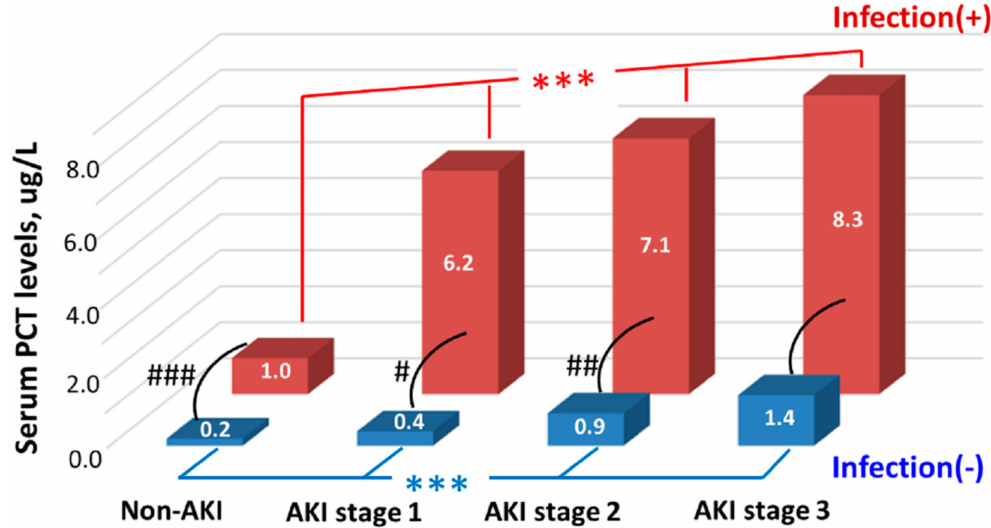
Figure 3. Serum PCT levels among groups stratified by AKI stages and infection states. Note: We used the median values to express the levels. *** indicated p < 0.001 among groups with different AKI stages. #, ##, ### indicated p < 0.05, <0.01, <0.001, respectively, between infected and non-infected groups. The figure was modified from the work of Huang et al. [25]. Abbreviations: AKI, acute kidney injury; PCT,